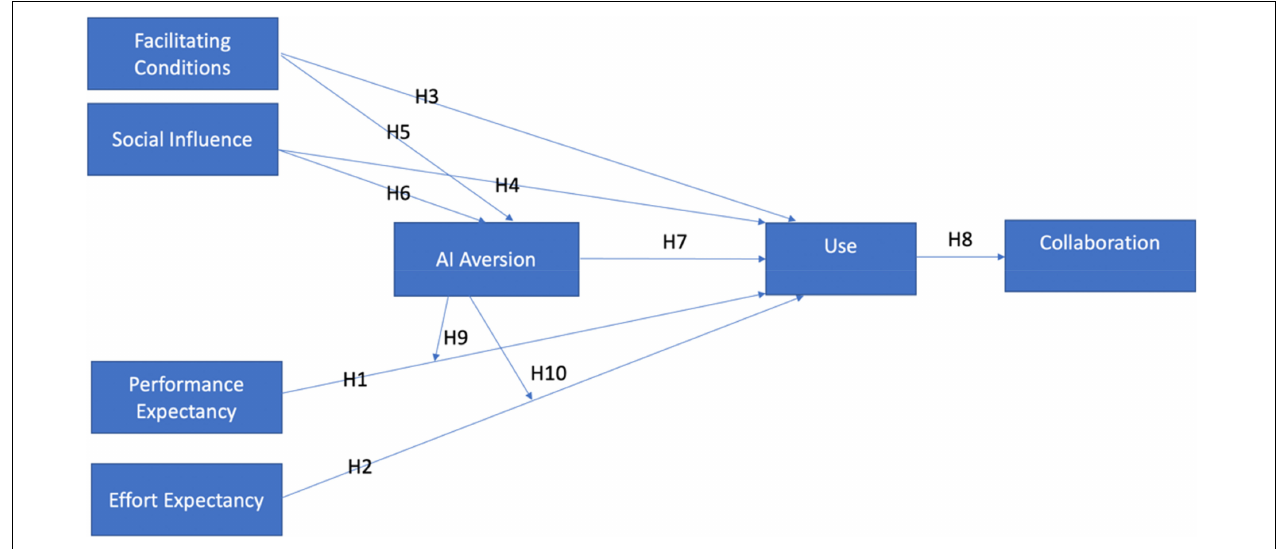
FIGURE 1 | Proposed research model. Source: primary data.